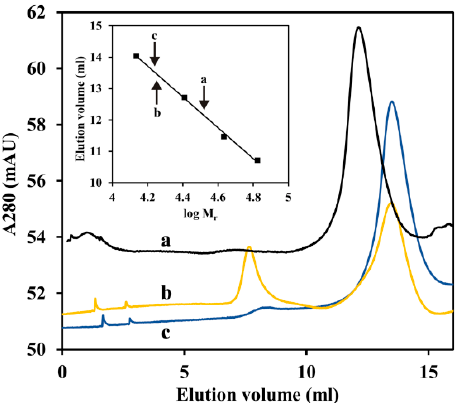
Figure 10. Determination of the molecular mass of diamide or arsenite treated ArsR1. First, 0.5 mL of sample (1.0 mg mL − 1 of proteins) was loaded onto a Superose 12 10/300 GL (GE Healthcare) analytical and preparative column equilibrated by 10 mM MOPS/0.1 M NaCl/15% glycerol (pH 7.5). The flow rate after sample application was 0.5 mL min − 1 . Marker proteins (solid squares in inset graph) were albumin (66.7 kDa), ovalbumin (43 kDa), chymotrypsinogen A (25.7 kDa) and ribonuclease A (13.7 kDa). Line a, ArsR1 alone; line b, ArsR1 in the presence of 1 mM diamide; line c, ArsR1 in the presence of 0.1 mM arsenite. Molecular masses calculated from the calibration curve were 33.1 kDa (a), 16.8 kDa (b) and 16.6 kDa (c). The theoretical molecular mass of the His-tagged monomer is 16,744